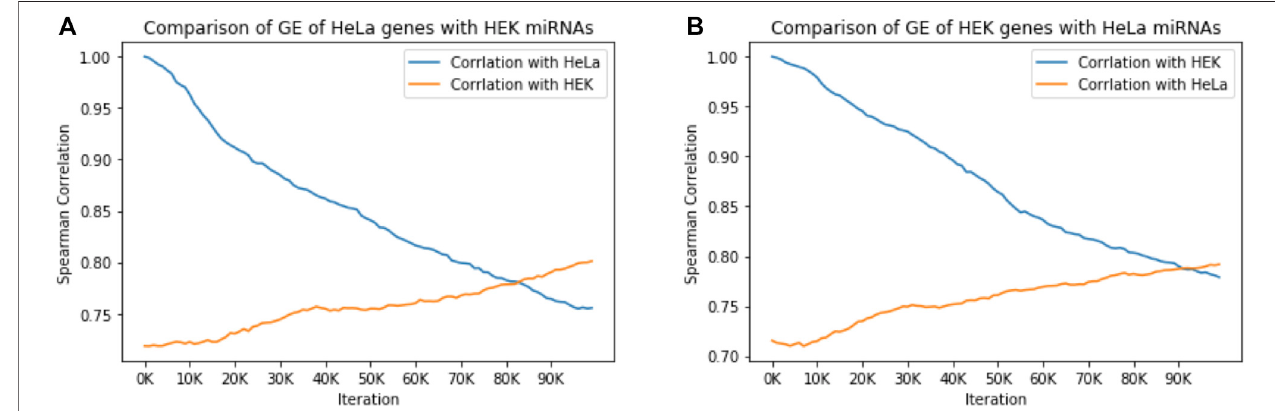
FIGURE 3| miRNAs governcell identity.The effectof miRNA expression of one cell type on gene expression (GE) of a different cell type ismeasured bySpearman correlationofgeneexpressionacrosstheCOMICS100,000iterations. (A) ThecorrelationofHeLaregulatedbyitsownmiRNAexpressionpro fi le(746genes),withHeLa gene expression regulated by the miRNA expression pro fi le from HEK-293 (514 genes). (B) The correlation of HEK-293 regulated by its own miRNA expression pro fi le (516 genes), with HEK-293 gene expression regulated by the miRNA expression pro fi le from Hela (514 genes). All correlation p -values are <